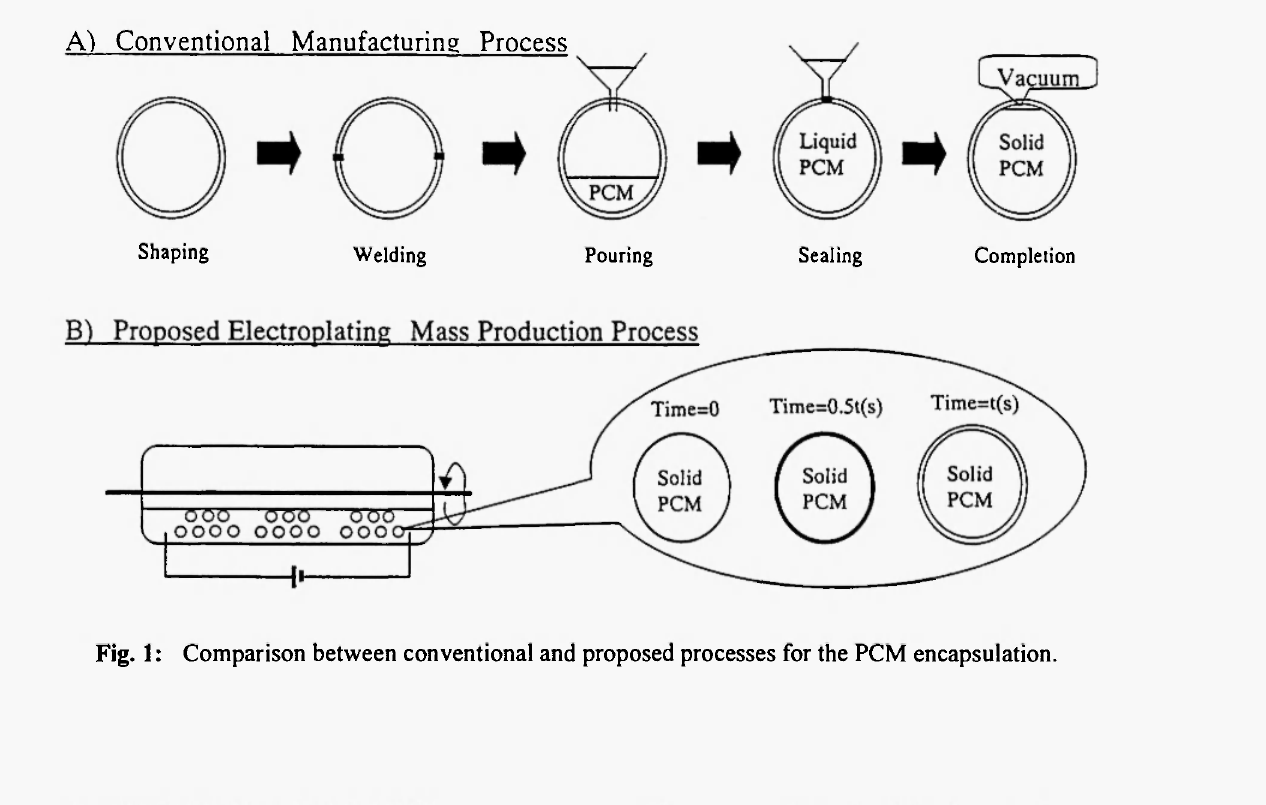
Fig. 1: Comparison between conventional and proposed processes for the PCM